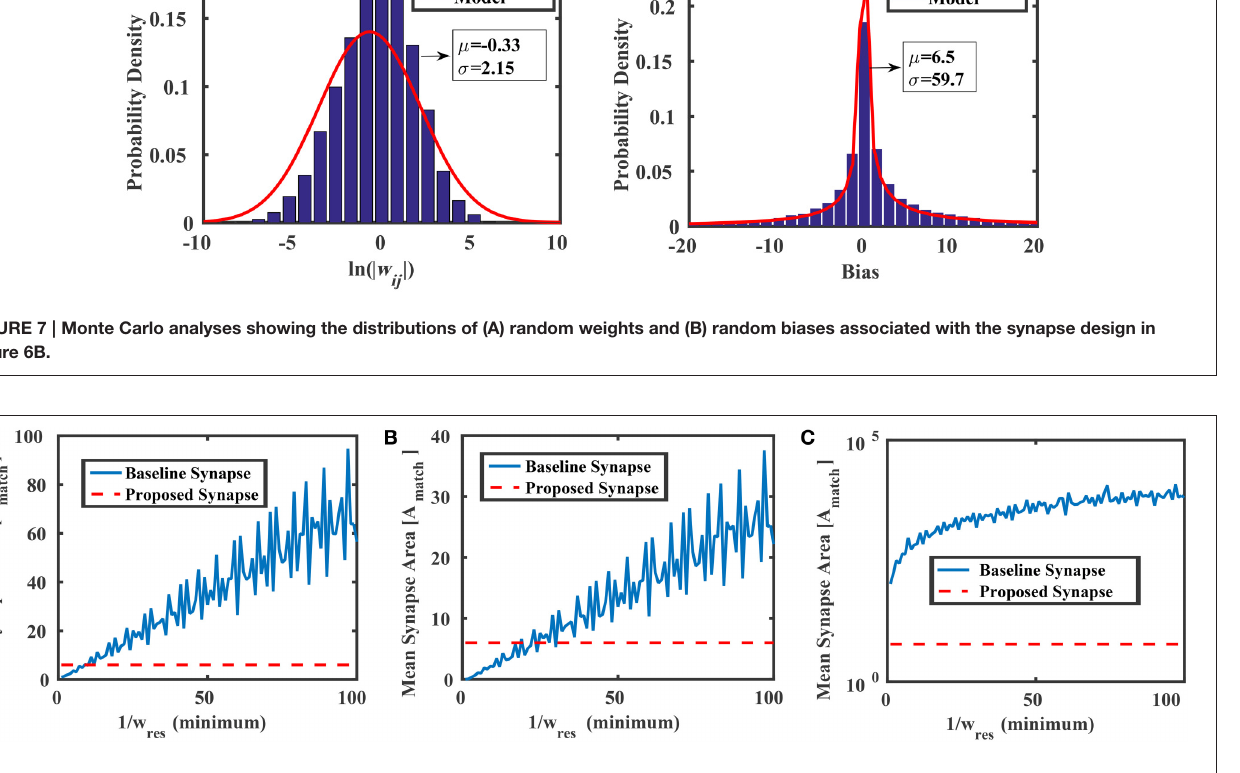
FIGURE 8 | Mean areas vs. the weight resolution for the baseline and proposed synapses circuits in Figure 6 where the baseline design was distributed (A) uniformly between − 1 and + 1 , (B) normally with 0 mean and std = 0.1, and (C) lognormally with 0 mean and std = 2.85. In each case, the proposed synapse design’s maximum area (6 A match ) is shown as a